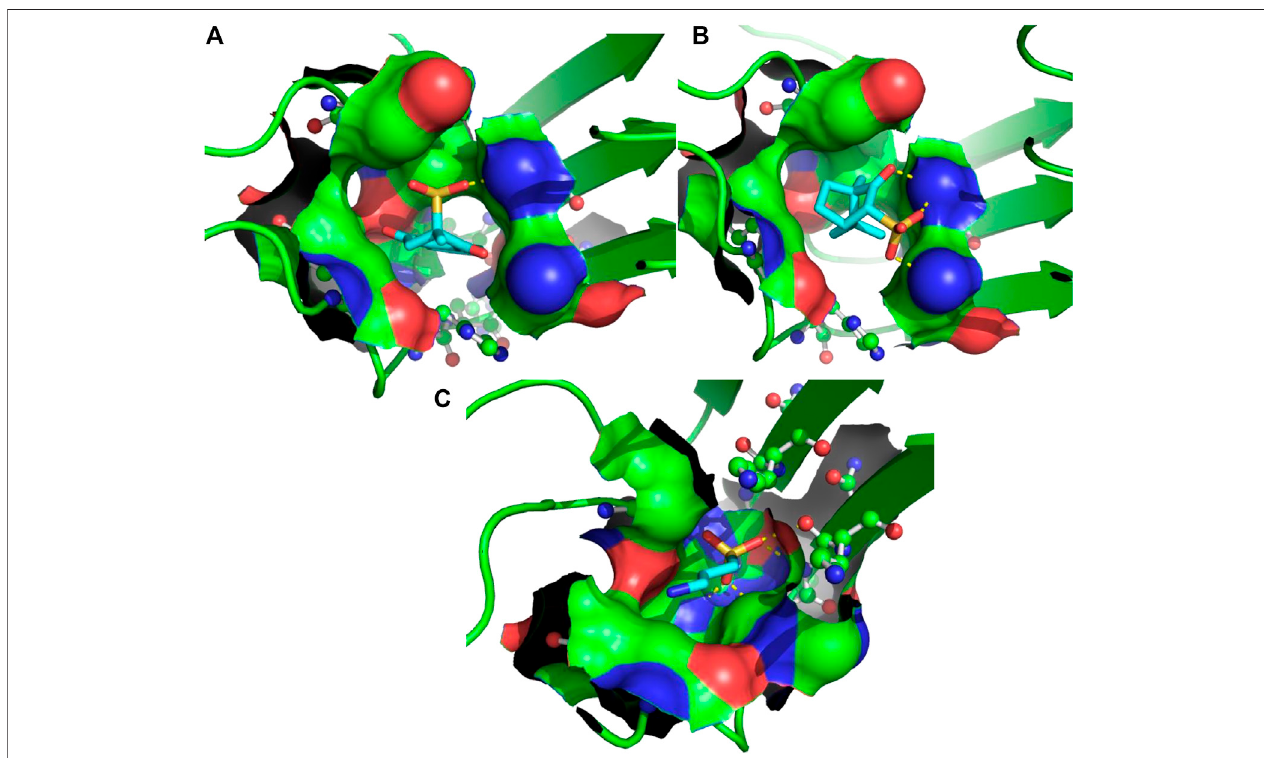
FIGURE 2 | 3D binding modes predicted from the AutoDock runs for menadione (A) , camphotamide (B) , and TRA (C) bound to A β peptide. The peptide-ligand bindingsiteisshownbythemolecularsurfaceandcoloredaccordingtothepeptideatomiccomposition.Thepeptide isshownasaribbondiagram, anditsresiduesare drawn as ball-and-stick models. Hydrogen bonds are visualized as a dashed lines. The ligand molecules are depicted in sticks, and hydrogen atoms are removed to enhance clarity.